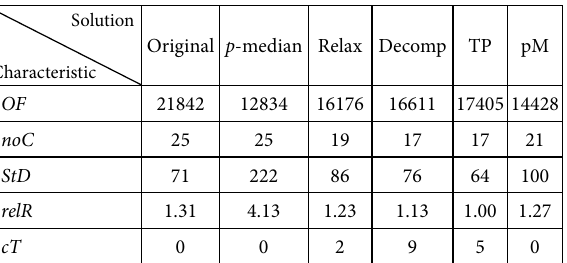
Table 8. Comparison of the results for the region